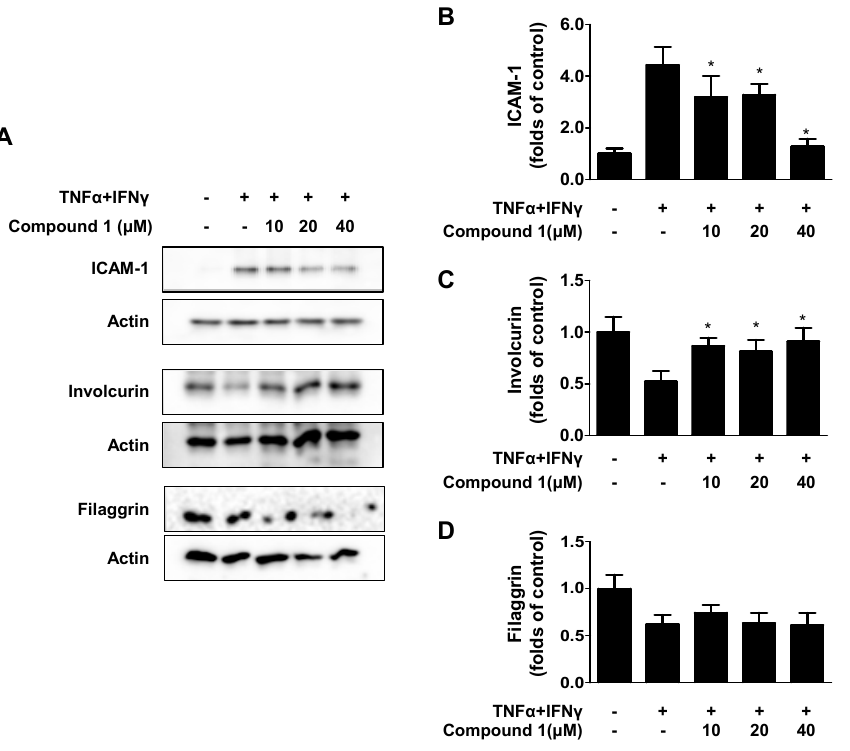
Figure 4. Effects of compound 1 on TNF- α /IFN- γ -induced ICAM-1 and barrier-related molecules, Filaggrin (FLG)/Involucrin (IVL) in HaCaT cells ( A – D ). Data are represented as the mean ± SD (n = 3). * p < 0.05 vs. TNF- α /IFN- γ -treated group.